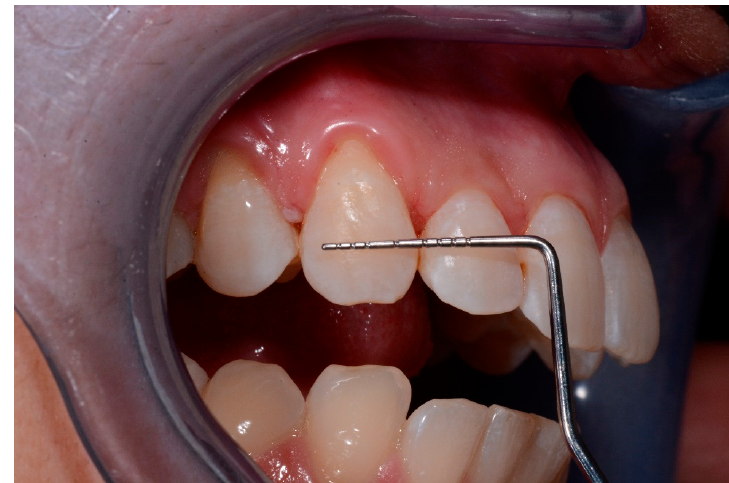
Figure 5. Baseline lesion with the periodontal probe . Figure 7. t1 lesion with the periodontal probe.